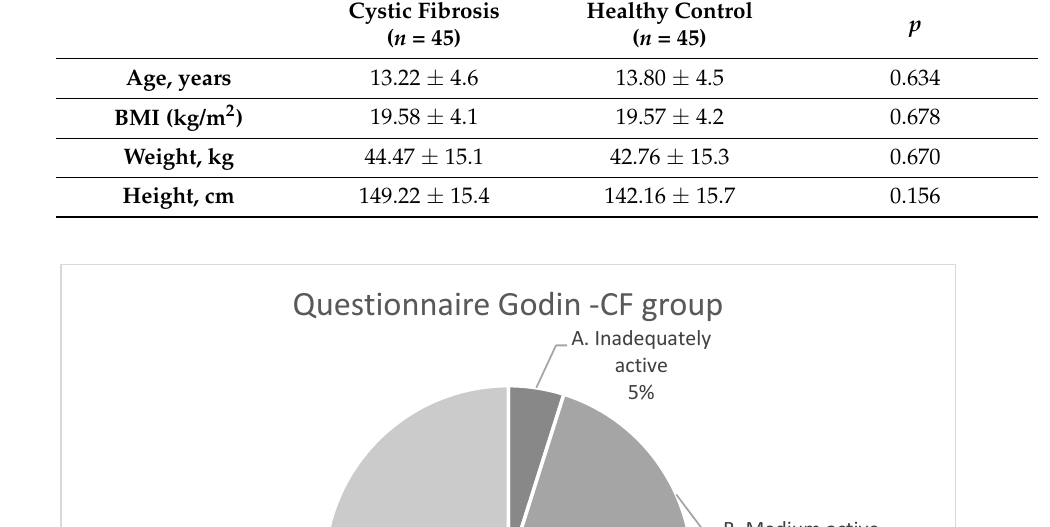
Table 1. Demographic characteristics of the study groups (pwCF and controls).